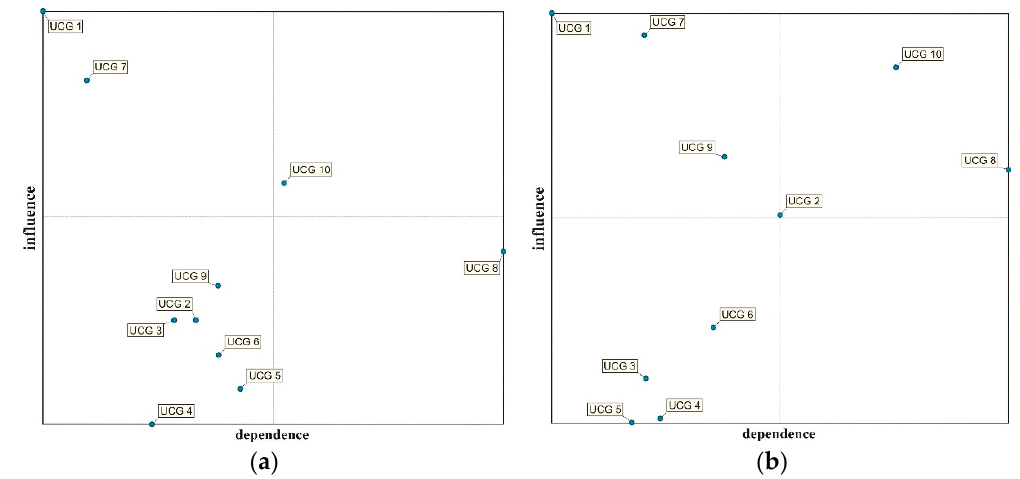
Figure 7. Maps of structural analysis: ( a ) direct influences/dependences MDI for UCG criterion; ( b ) indirect influences/dependences MII for UCG criterion.